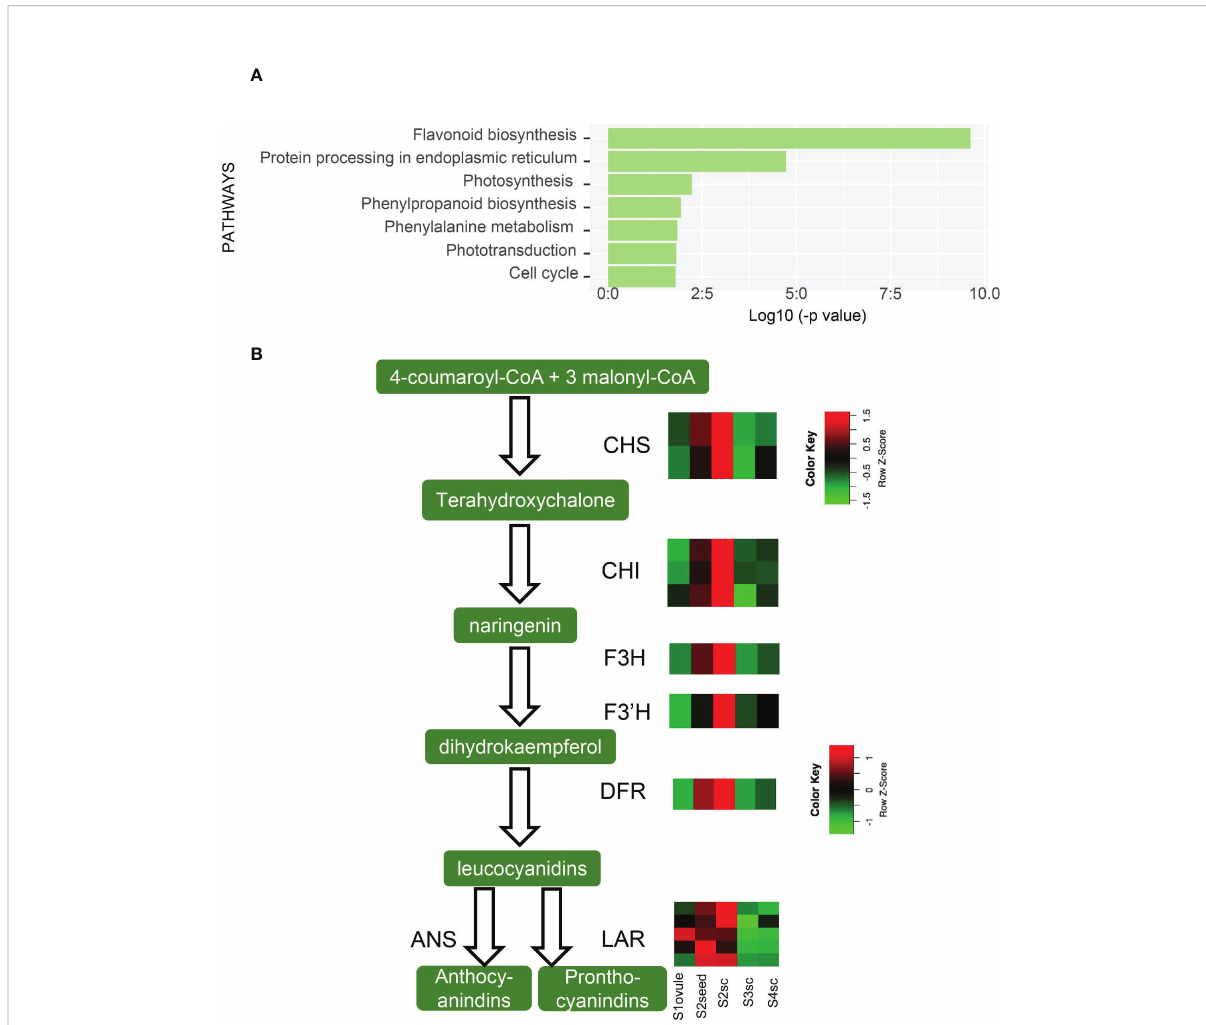
FIGURE 5 Up-regulated pathways of S3sc and seed coat-related gene expression. (A) Enriched KEGG pathways are higher expressed in S3sc compared to S2sc. (B) Flavonoid biosynthetic pathway and expression pattern of key genes involved. The expression levels are shown in heatmaps. The scale bars show the Z-score range. CHS , ( chalcone synthase ); CHI , ( chalcone- fl avanone isomerase ); F3H , ( fl avanone 3-hydroxylase ); F3 ’ H , ( fl avonoid 3 ’ -hydroxylase ); DFR , ( dihydro fl avonol 4-reductase ); ANS , ( anthocyanidin synthase ); LAR , ( leucoanthocyanidin reductase